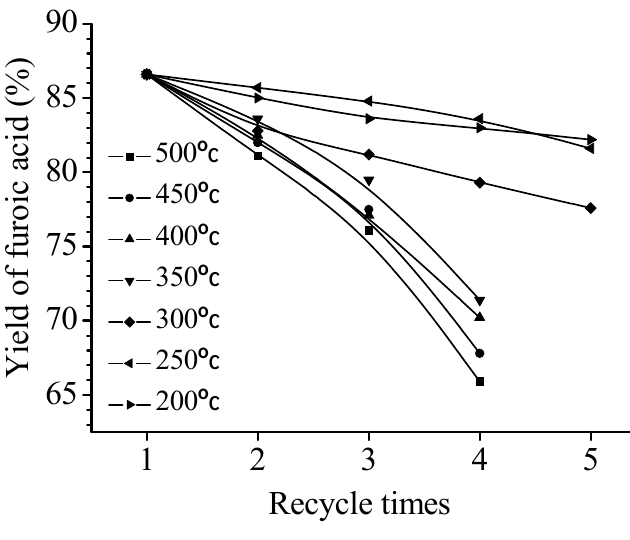
Figure 9. Effect of CuO recycling temperature on furoic acid